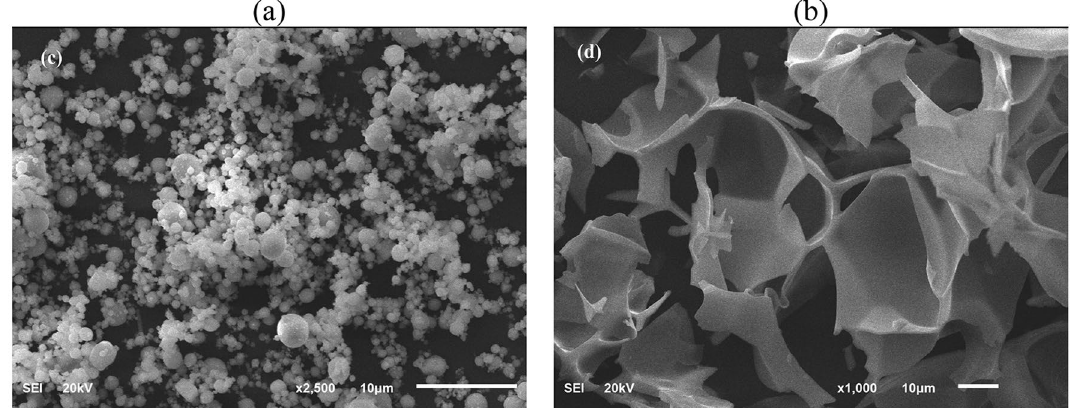
Figure 2. SEM for ( a ) Micromax and ( b ) perlite at 10